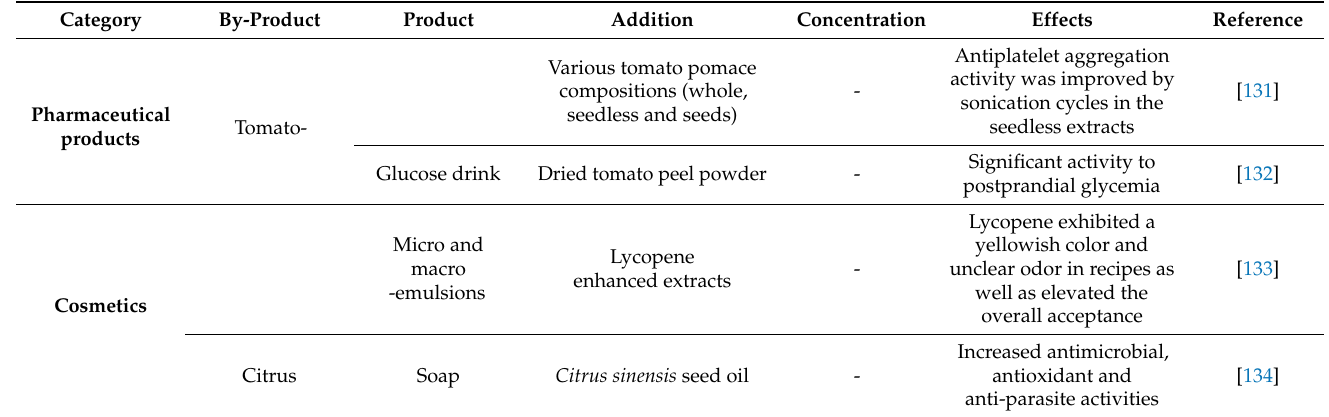
Table 5. Addition of agri-food by-products to pharmaceutical and cosmetic